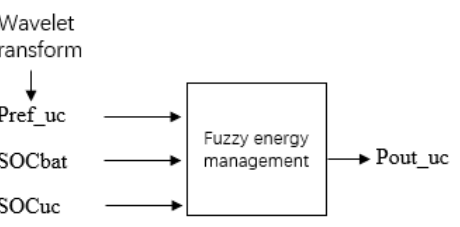
Figure 12. Control diagram of the ultra-capacitors output power.